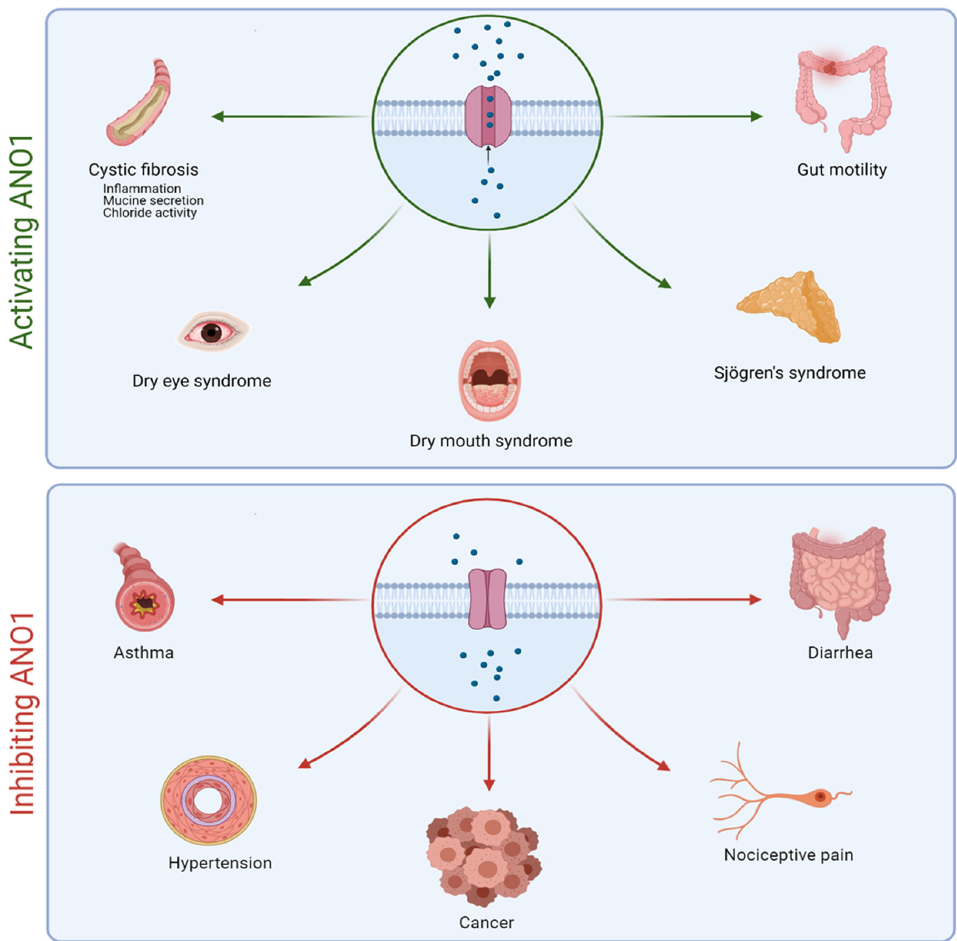
Figure 2. Schematic representation of the positive impacts of activating or inhibiting ANO1 in dif ‐ ferent pathologies.